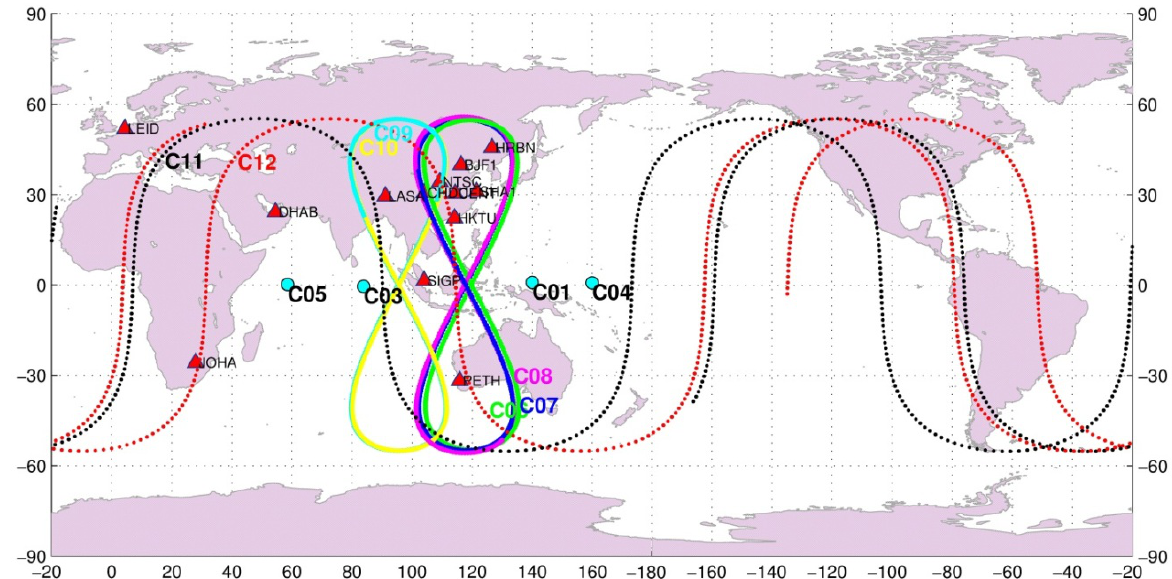
Figure 1. Ground tracks of BDS GEO satellites (C01, C03, C04, C05), IGSO satellites (C06, C07, C08, C09, G10), and MEOs (C11, C12) and station distribution of the BETS experimental tracking stations